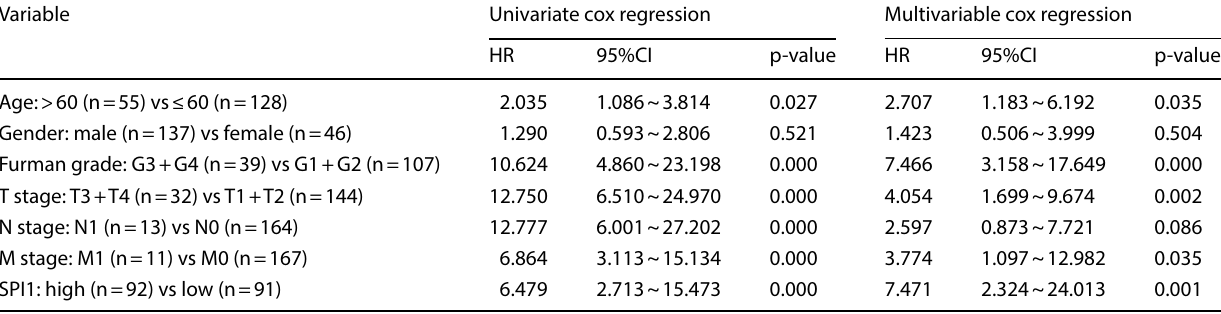
Table 1 Univariate and multivariable cox regression of SPI1 expression for overall survival in patients with ccRCC